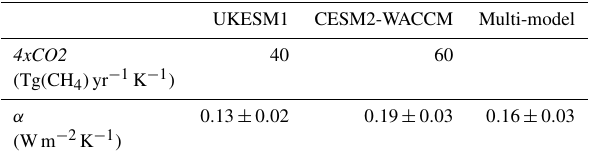
Table 13. Sensitivity of wetland emissions to 4xCO2 in two models. Feedback parameter assuming pre-industrial conditions. Uncertain- ties for each model assume a 14% uncertainty in the methane ra- diative efficiency (Etminan et al., 2016). Uncertainties in the multi- model results are the standard deviation across the